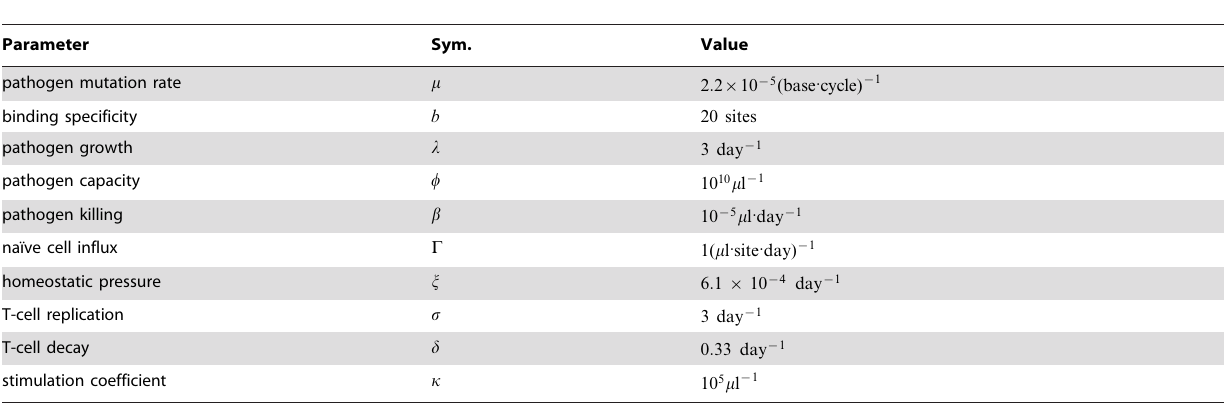
Table 1. Parameters used in all simulations unless otherwise noted.